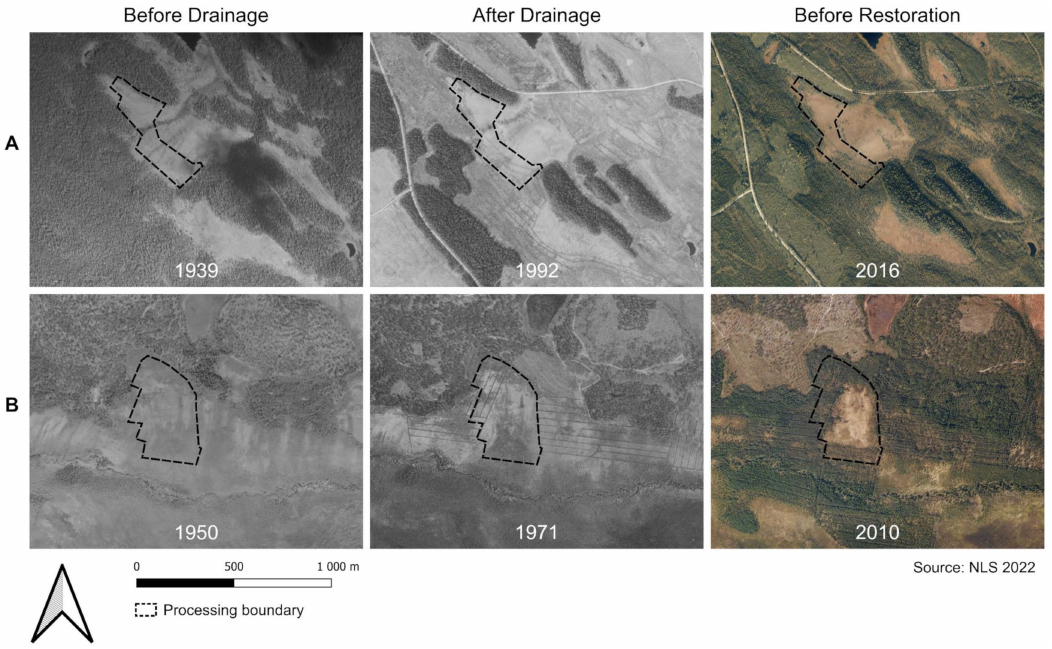
Figure 2. Historical development of Loukkusuo ( A ) and Iso Leväniemi ( B ) sites. The pristine states can be assessed from the aerial photos before drainage. The photos after drainage show the developing drainage networks and the first signs of forestry actions. The photos before restoration show the tree cover of the drained areas at its